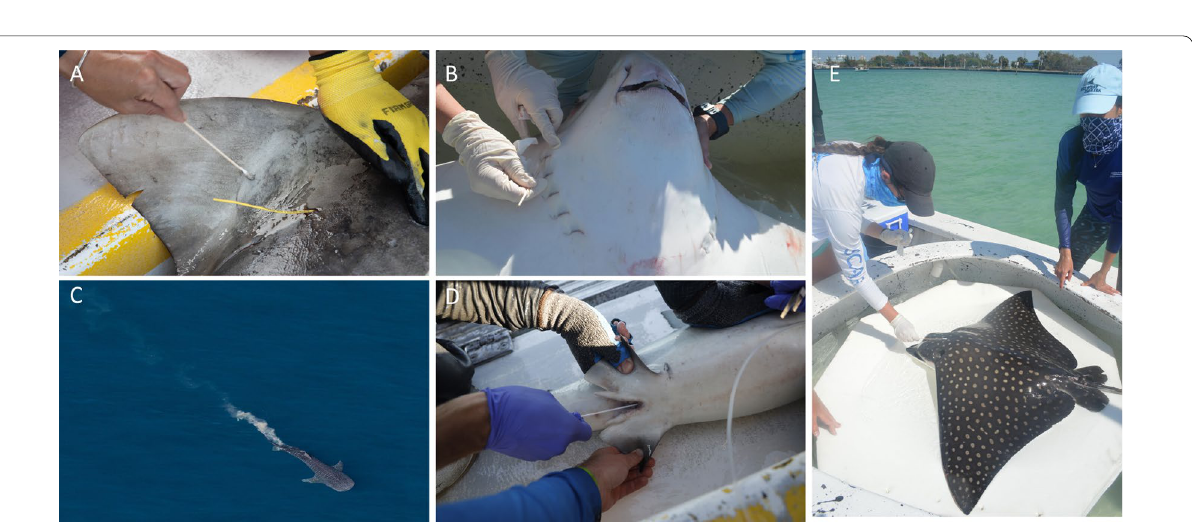
Fig. 3 Despite the difficulty of sample collection, elasmobranch microbiomes have been sampled from diverse body niches. Swabbing of the skin/ mucus ( A , E ) and gill ( B ) is relatively non‑invasive and captures microbiomes reflecting both host‑specific taxonomic signatures, as well as signatures of the surrounding seawater water microbiome. Host‑specific signatures may be driven partly by variation in mucus content and prevalence, such as between sharks and rays. Sampling of gastrointestinal microbiomes has involved opportunistic sampling of feces ( C ) or swabbing of the cloaca ( D ), with cloacal communities representing a transition between external and internal microbiomes. Few studies have examined microbiome variation along the GI tract in dissected individuals. Diet, intestinal anatomy, and host foraging ecology may influence GI microbiome structure. Panel A Dorsal skin swab of a tiger shark (Mote Marine Laboratory). Panel B Gill swab of a spotted eagle ray (Mote Marine Laboratory). Panel C Aerial photograph of a whale shark defecating (Tiffany Klein, Ningaloo Aviation). Panel D Cloaca swab of a tiger shark (Mote Marine Laboratory). Panel E Dorsal swab of a spotted eagle ray (Mote Marine